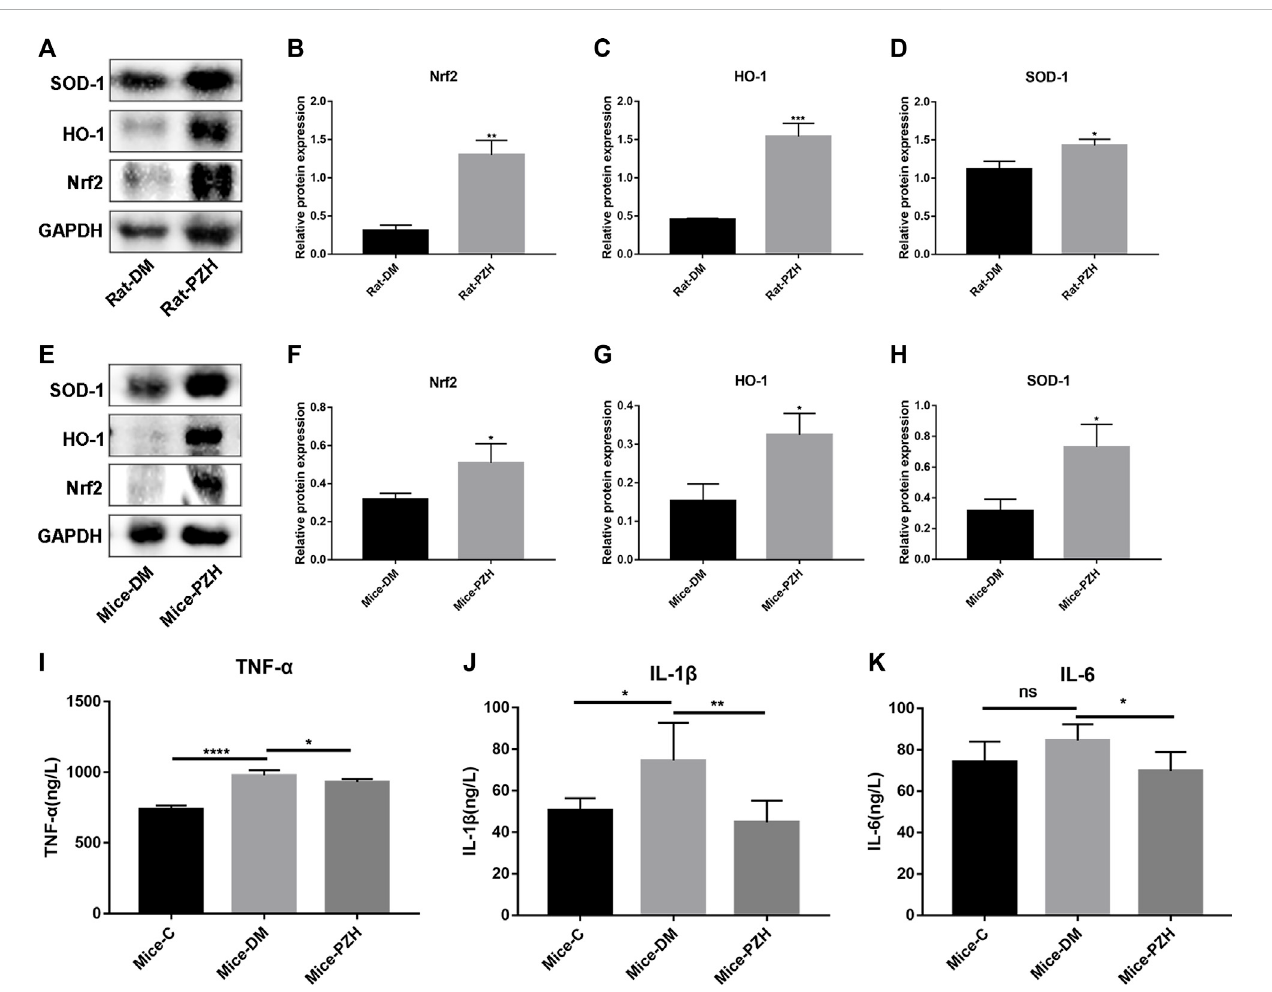
FIGURE 4 PZH activates the Nrf2/ARE pathway in diabetic wound tissue and reduces serum in fl ammatory factors in diabetic mice. (A – H) Western blotting and quanti fi cation of Nrf2, HO-1, and SOD-1 in the wound tissue of diabetic rats (A – D) or mice (E – H). * p < 0.05, ** p < 0.01, *** p < 0.001 (n = 3). (I – K) ELISA detection of serum in fl ammatory factor levels in different groups of mice: TNF- α (I) , IL-1 β (J) , IL-6 (K) . **** p < 0.0001, ** p < 0.01, * p < 0.05 (n = 5). Data are expressed as the mean ± SD. C: normal control group; DM: diabetic control group; PZH: PZH-treated